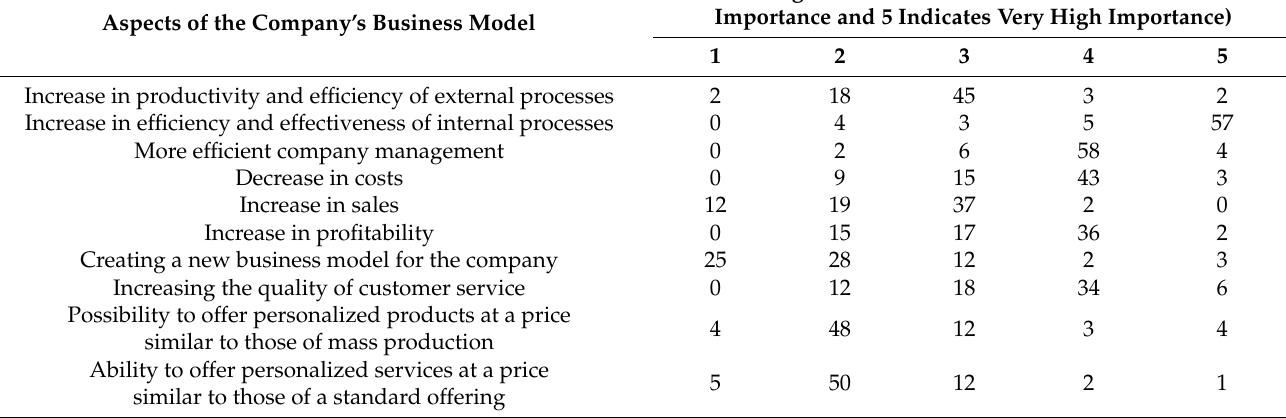
Table 3. Assessment of the strength of the impact of the implementation of the pillars of Industry 4.0 on various aspects of the company’s business